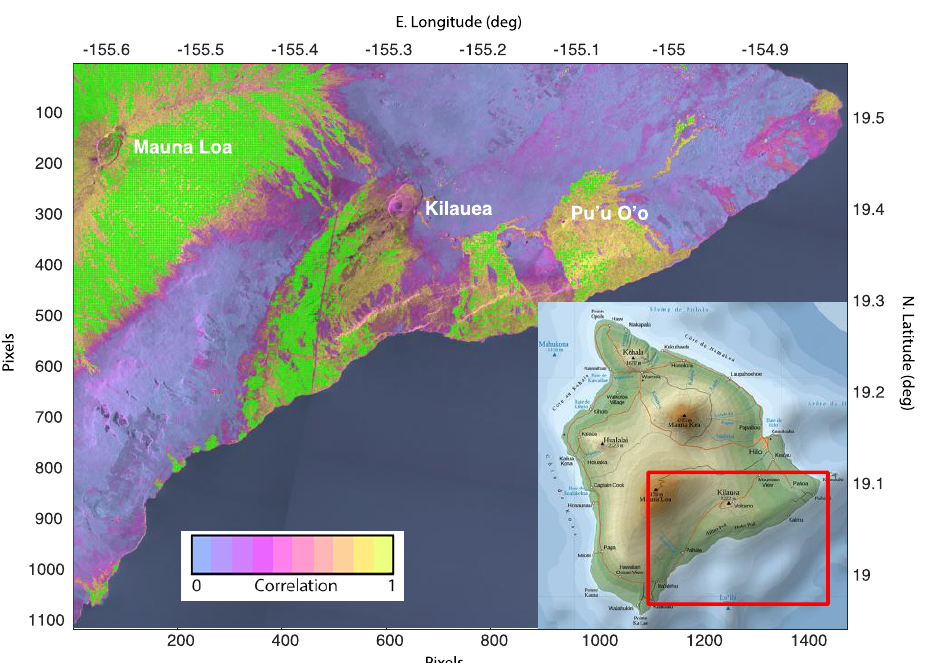
Figure 1. Reference locations from a stack of interferograms over Hawaii. The data comprise 50 single-look complex (SLC) scenes acquired from January to December 2018, and the stack in this image is formed from all possible interferograms with time baselines of 12 days or less. The green squares, which are not part of the colorbar for correlation, show the reference points, which are the points whose correlation exceeds 50% in all interferograms. Note that portions of Hawaii are highly vegetated, and lead to the large regions of consistent decorrelation (purple color) in the image.